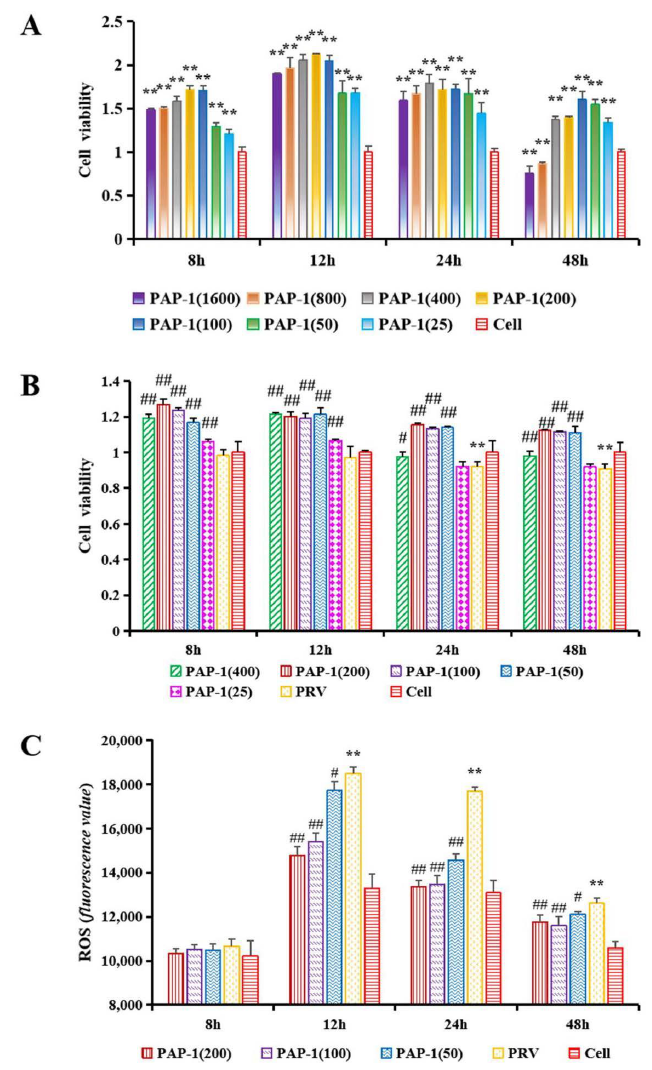
Figure 6. The effect of PAP-1 on the activity of RAW264.7 cells ( A ). The regulation of PAP-1 on the activity ( B ) and ROS level ( C ) in PRV-infected RAW264.7 cells. (means ± SD, n = 4). Bars with # indicate a significant difference between the PRV group, respectively ( p < 0.05). ** and ## show the most significant differences with cell group and PRV group, respectively ( p < 0.01).